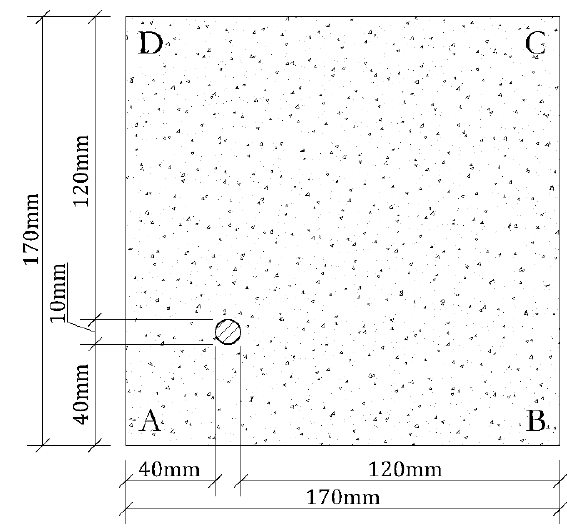
Figure 2. Cross-section